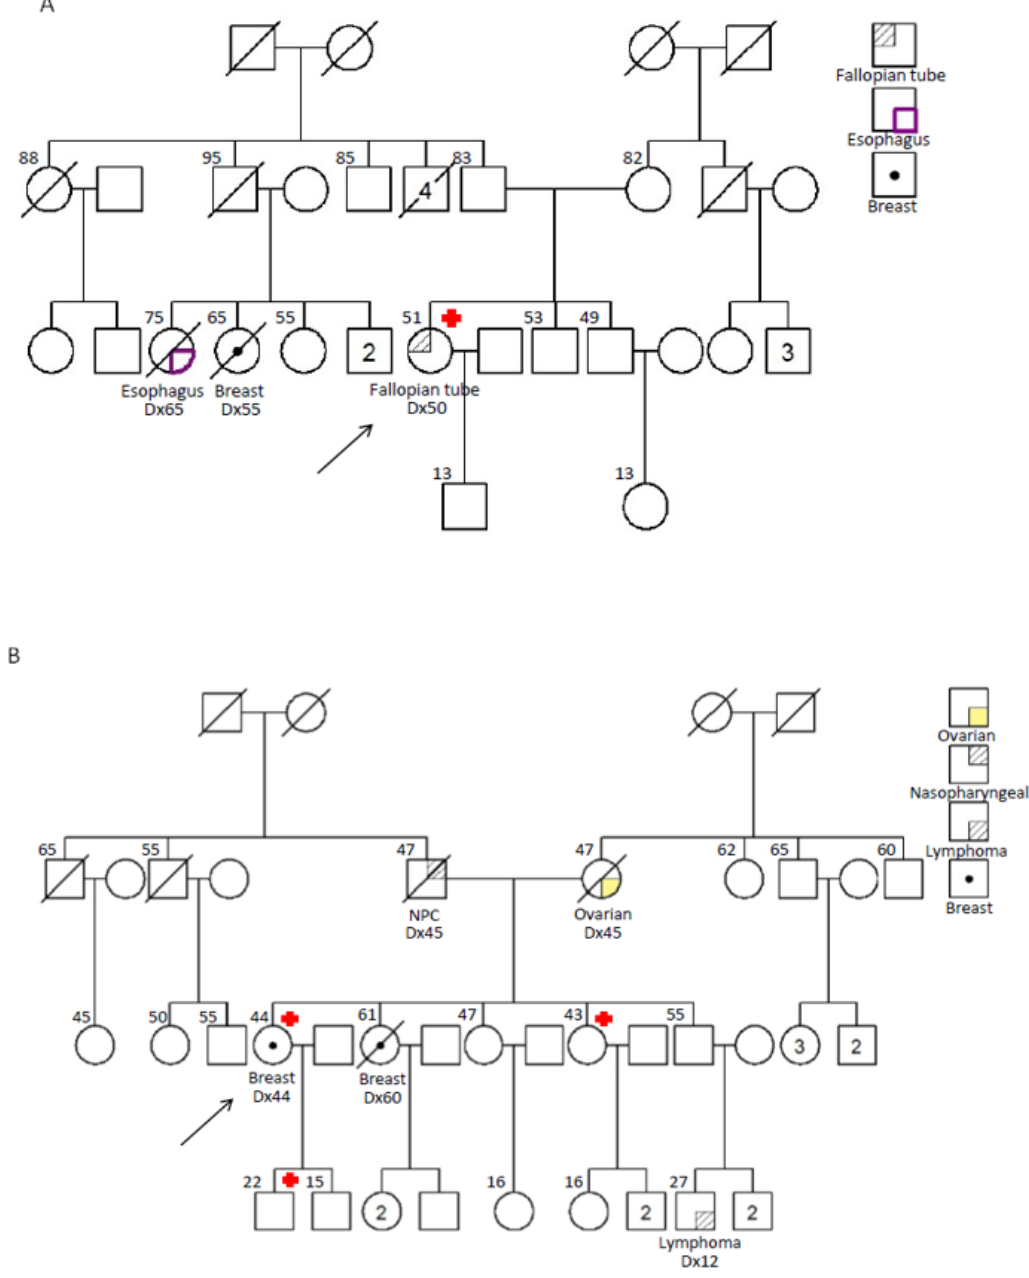
Figure 3. ( A , B ) Pedigree of the 2 families in our Hereditary Breast Cancer Family Registry with BRCA1 : c.5406+7A>G; r.5333_5406del74; p.Asp1778Glyfs*27 mutations. : carrier of BRCA1 : c.5406+7A>G; r.5333_5406del74; p.Asp1778Glyfs*27